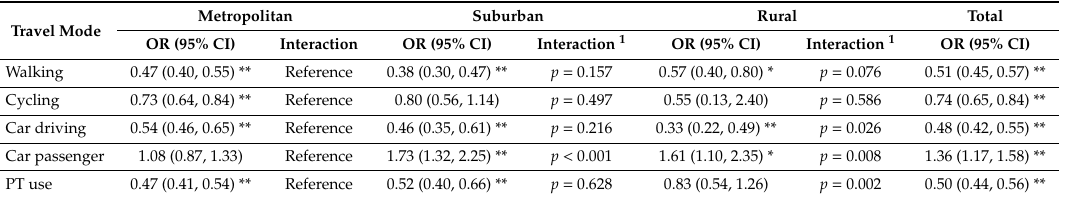
Table 3. Odds ratios of using each travel mode by frail participants (reference: non-frail) for the whole sample and stratified by